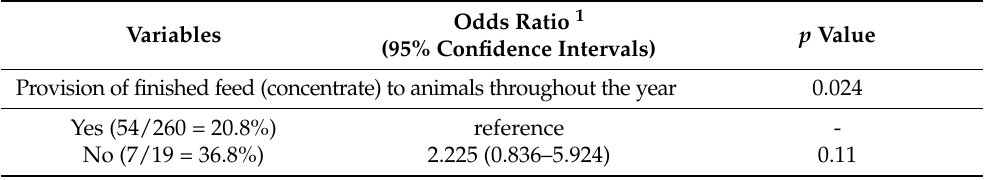
Table 7. The results of the multivariable analysis for the presence of Trichuris spp. in faecal samples from 279 sheep flocks in a countrywide investigation in